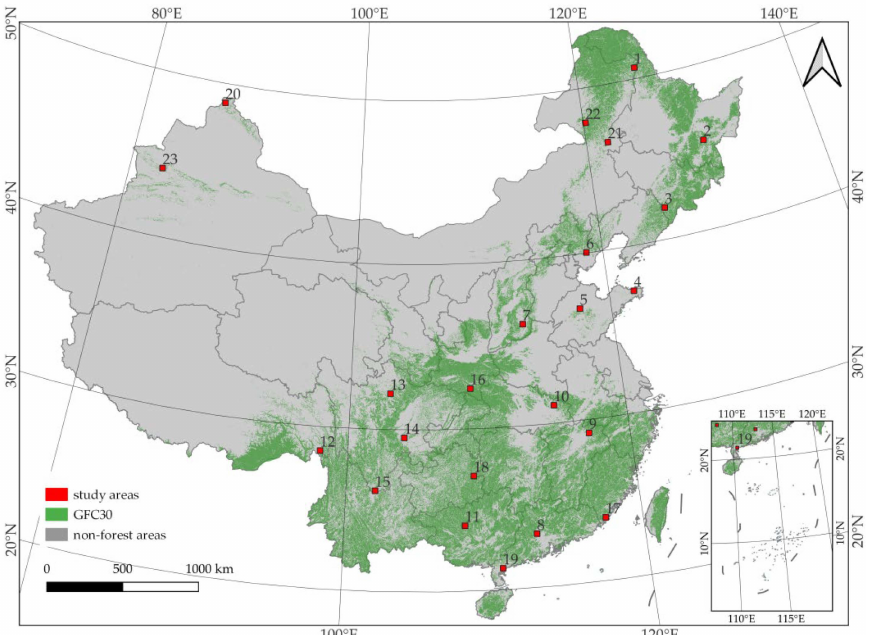
Figure 1. Distribution of study areas. The red areas are the study areas chosen for this paper, and the green area represents the GFC30 forest products in the Chinese region.